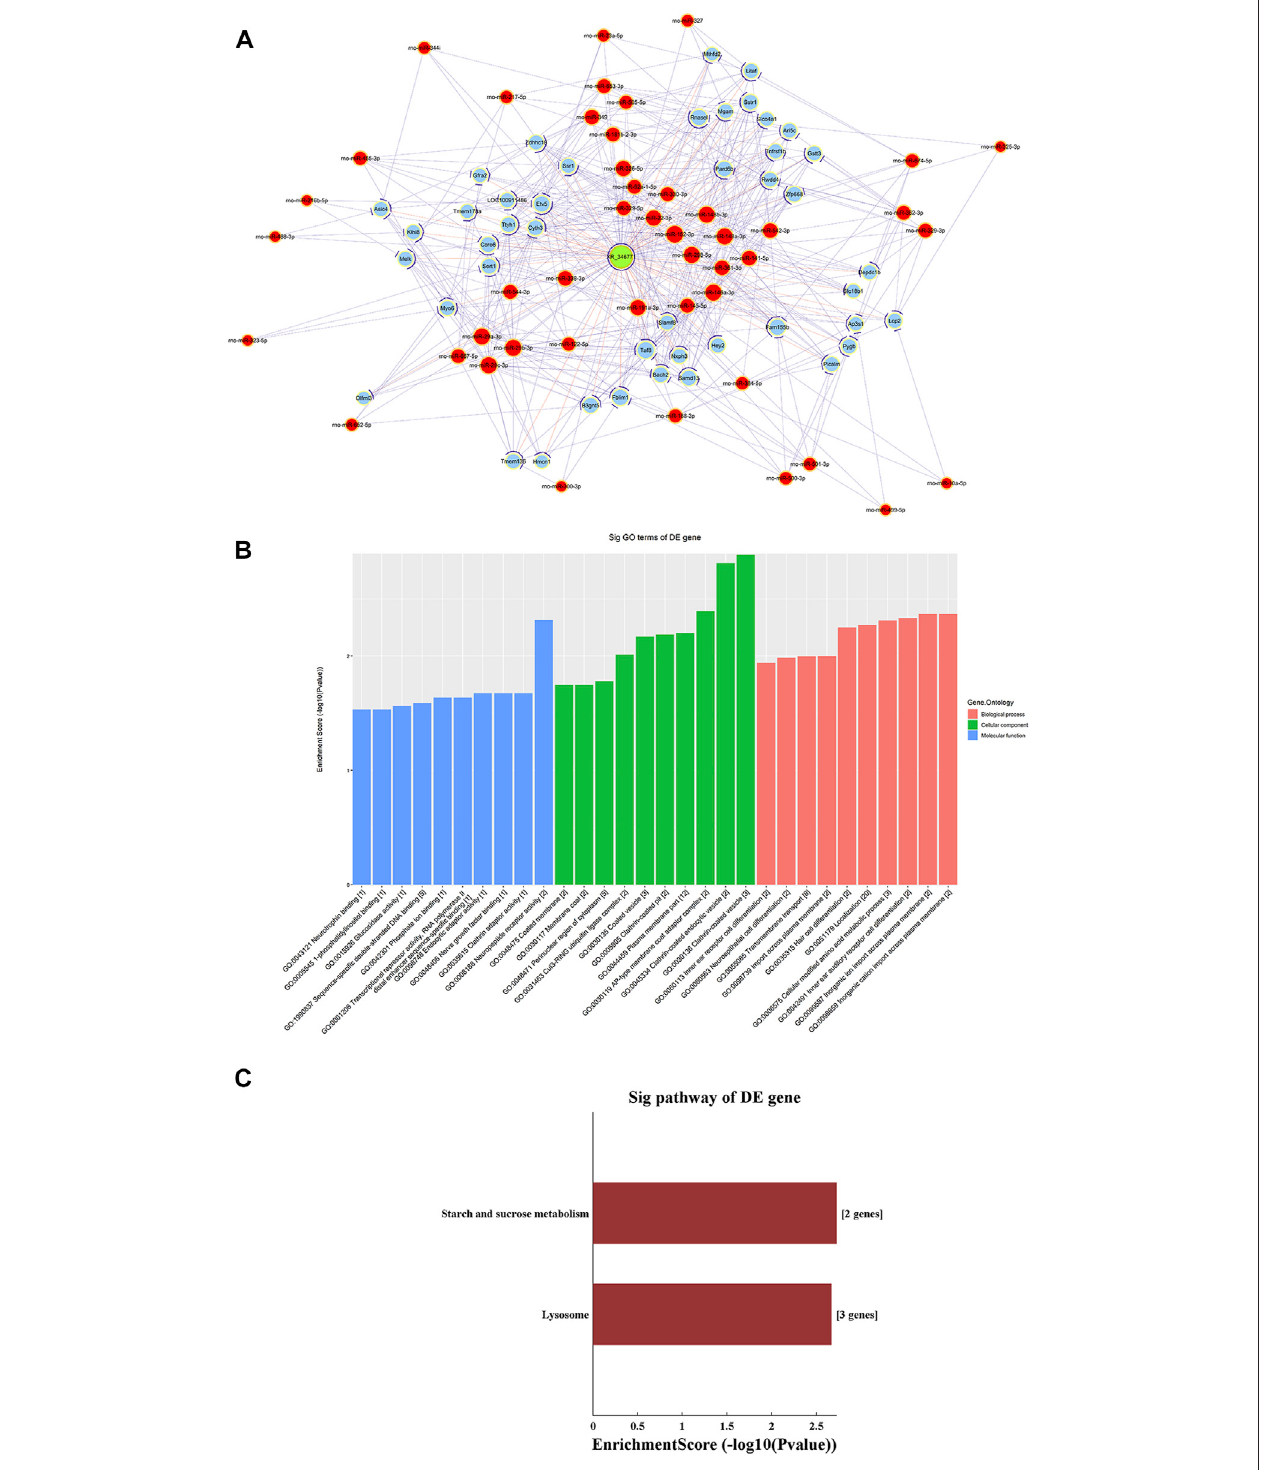
FIGURE 6 | LncRNA XR_346,771-miRNA-mRNA ceRNA analysis. (A) The ceRNA network of XR_346,771 – miRNA – mRNA. Red circles represent miRNAs, blue circles represent mRNAs, and green circles represent lncRNAs. (B) Ten most enriched GO terms involved in the ceRNA network. (C) KEGG pathways involved in the ceRNA network. ceRNA, competing endogenous RNA.